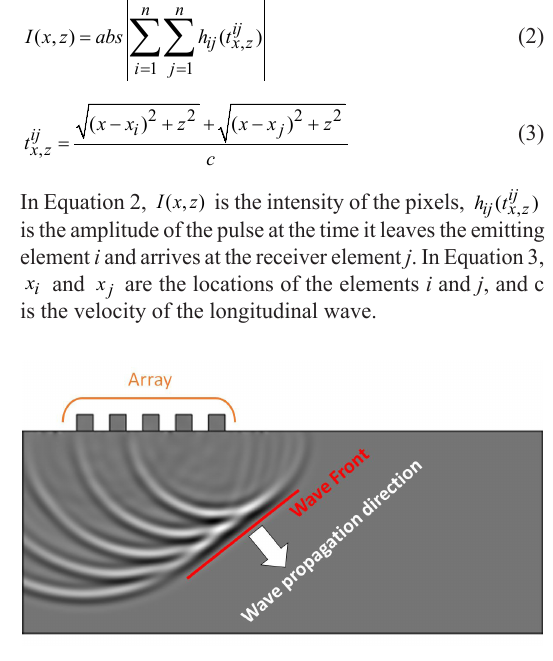
Figure 2. Wave front in a probe of phased array.